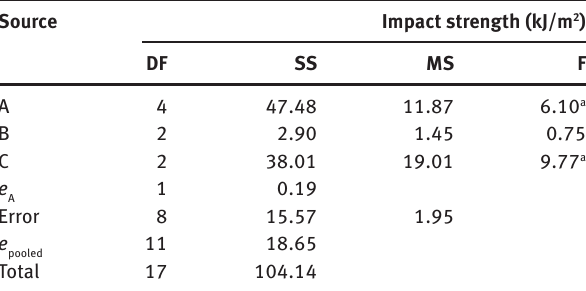
Table 6: ANOVA table for the impact properties of